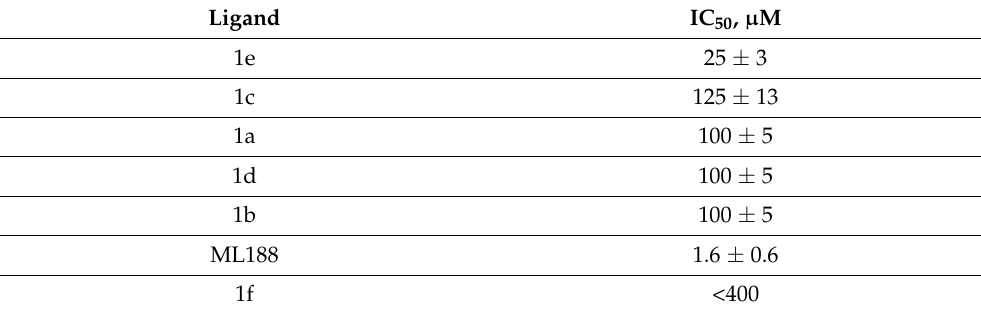
Table 3. SARS-CoV-2 Mpro-inhibiting activity of the new triterpene amides in comparison with non-covalent inhibitor